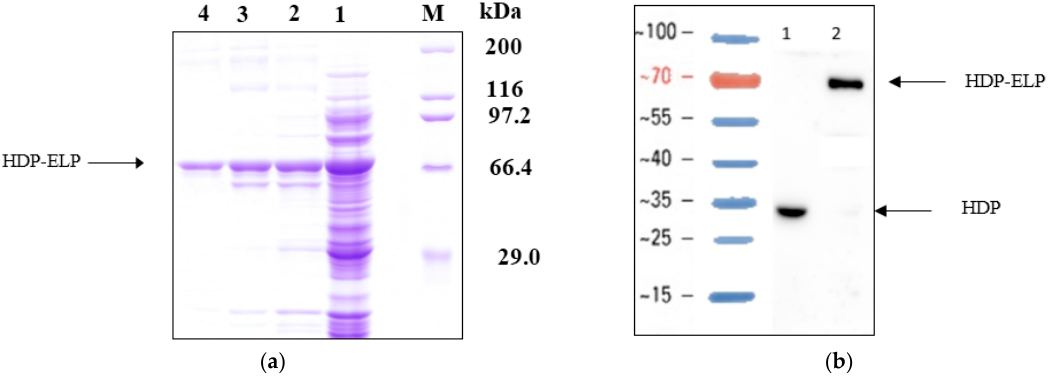
Figure 1. Analysis of purified heme ‐ dependent peroxidase (HDP) ‐ elastin ‐ like polypeptide (ELP) by sodium dodecyl sulfate polyacrylamide gel electrophoresis ( a ) and Western Blot ( b ). In ( a ), lane M is for Mark proteins (KDa); lane 1 is for all proteins expressed; lanes 2, 3 and 4 are for the purified HDP ‐ ELP after first, secondary, and third round purifications, respectively. In ( b ), lane 1 is for HDP and lane 2 for HDP ‐ ELP.